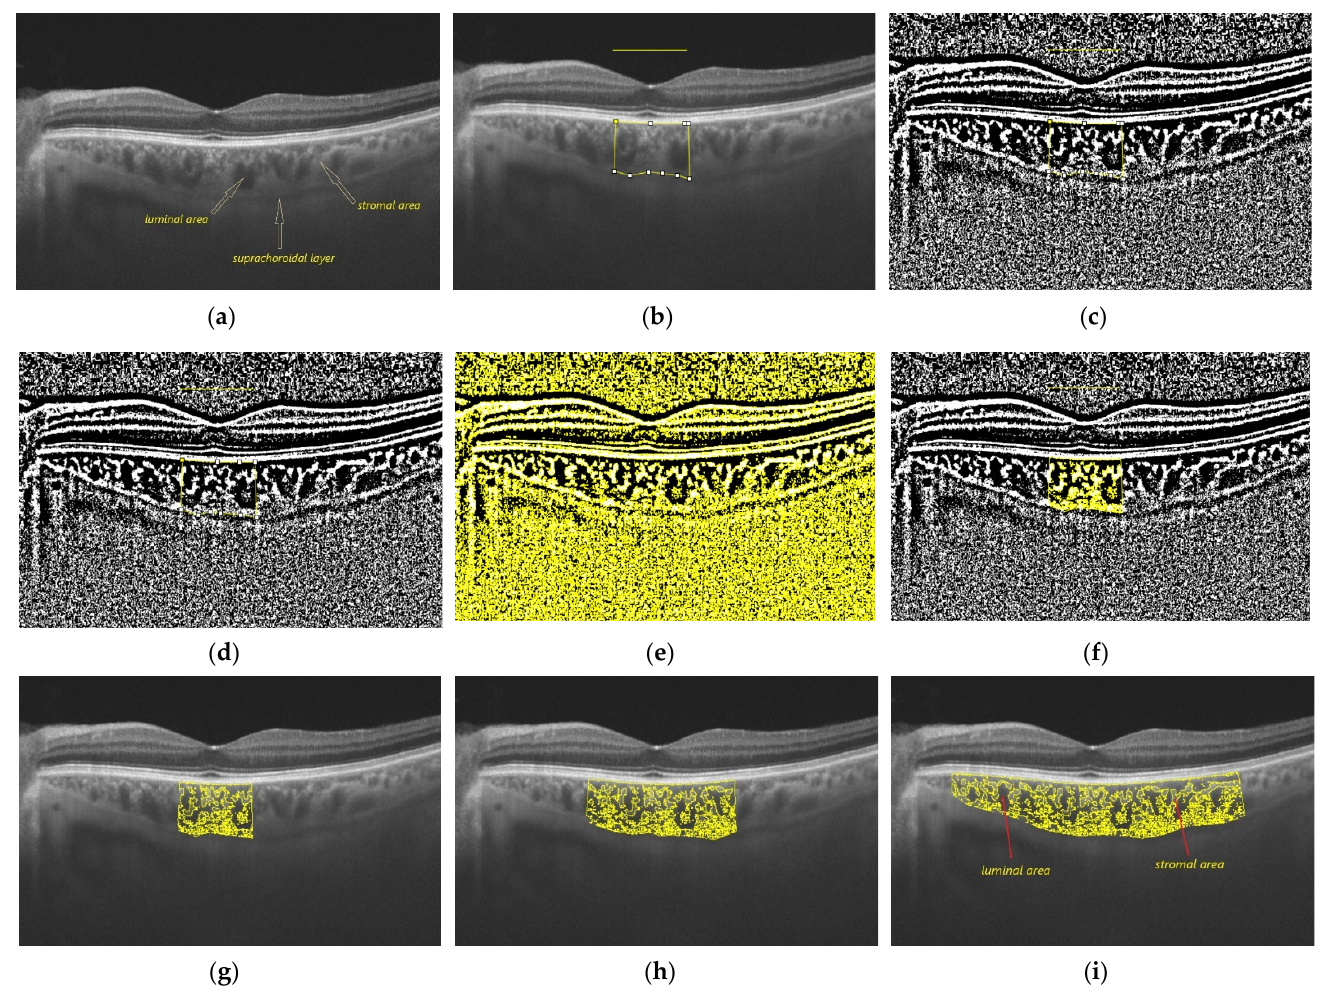
Figure 1. Illustration of image binarization protocol: ( a ) SS-OCT image of a patient with DM without DR; the suprachoroidal layer, luminal area, and stromal area are indicated by arrows; ( b ) a polygonal selection of the choroid under a 1.5 mm horizontal line centered on the fovea; ( c ) image binarization by Niblack method; ( d ) small adjustments of the polygon points after a better visualization of the choroidal-scleral junction; ( e ) color thresholding to highlight the vascular area; ( f ) luminal area; ( g ) final result after overlaying the luminal area measured for the area under the 1.5 mm horizontal line centered on the fovea on the SS-OCT image; ( h ) representation of the final result after applying the same protocol for the area under the 3 mm horizontal line centered on the fovea; ( i ) representation of the final result after applying the same protocol for the area under the 6 mm horizontal line centered on the fovea.